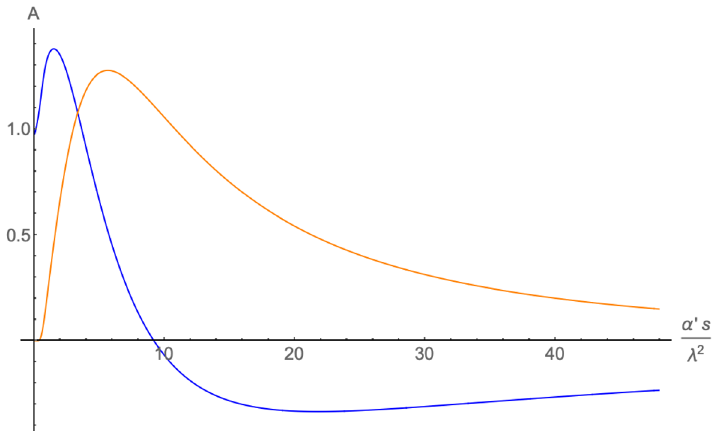
Figure 5 . Top: real (blue line) and imaginary (orange) parts of the amplitude computed in the soft wall model. The parameters used are cos θ = 0 . 8 , ∆ = 8 . Both parts are smooth functions with no